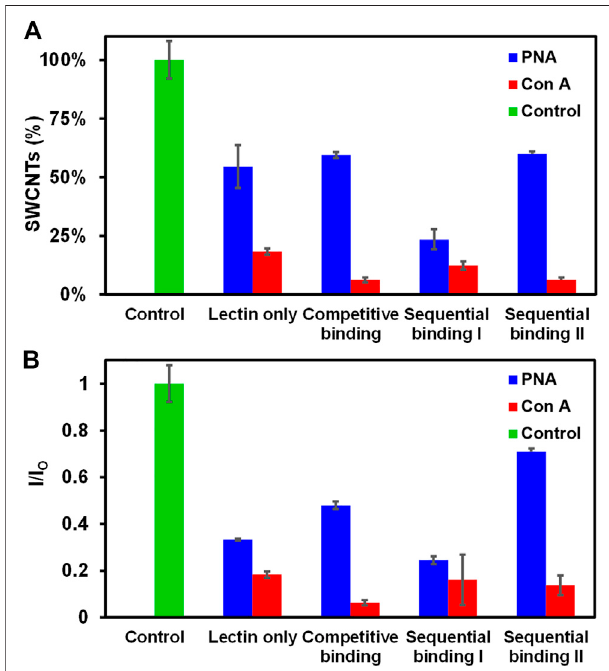
FIGURE 3 | Comparison of different methods of lectin interactions with Glyco-SWCNTs. (A) Percentage of SWCNTs remaining in the supernatant determined from the sample absorption at 780 nm and the corresponding changes in (B) the NIR emission intensity ratio at the maximum E 11 peak wavelength(i.e.,1013 nm)ofGlyco-SWCNTsafterincubation withlectinsand free sugar ß -lactose. The control was performed by measuring the optical spectra of Glyco-SWCNTs only incubated in PBS buffer solution for 5 min without adding lectins and free sugar ß -lactose. The sample concentrations are 4.21 ± 0.13 μ g/ml nanotubes for Glyco-SWCNTs, 0.77 ± 0.01 µM lectin (i.e., PNA and Con A, respectively), and 0.36 ± 0.05 mg/ml free sugar ß -lactose, respectively. A fi xed excitation wavelength of 532 nm laser was used for NIR fl uorescence spectra measurements.